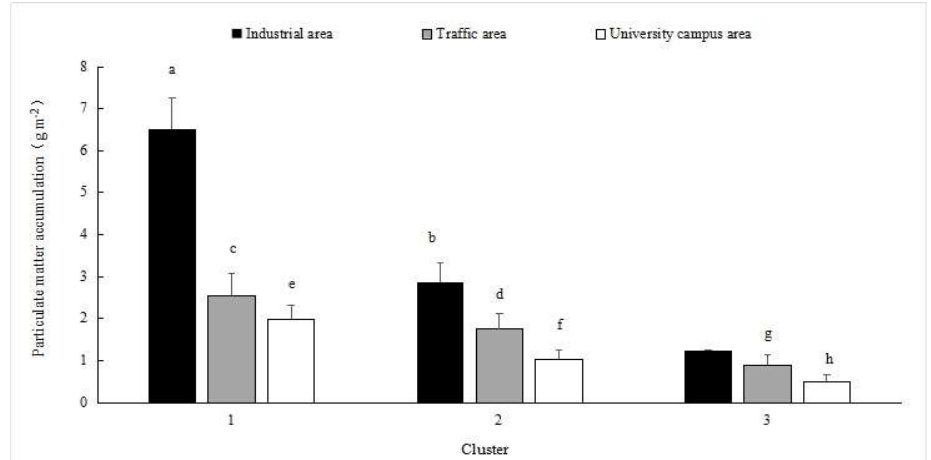
Figure 4. Accumulation of total particulate matter (means ± SE) on the leaves in the three clusters found in the three functional zones. Bars are means ± SE. Treatments with the same letter (a–h) were not significantly different (ANOVA with Duncan test, p < 0.05). SE is standard error.